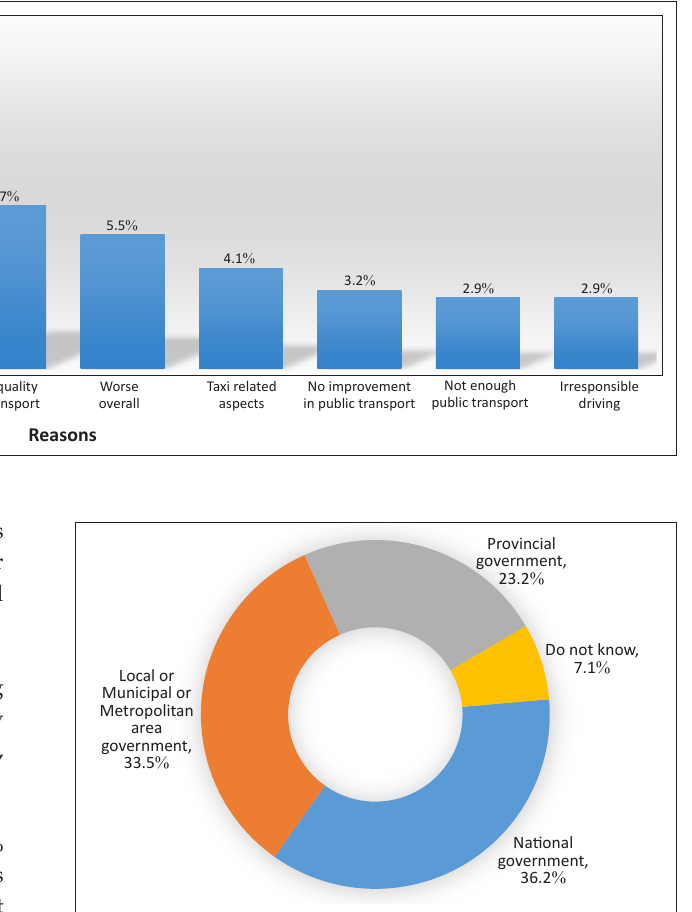
FIGURE 8: Government level responsible for transport.